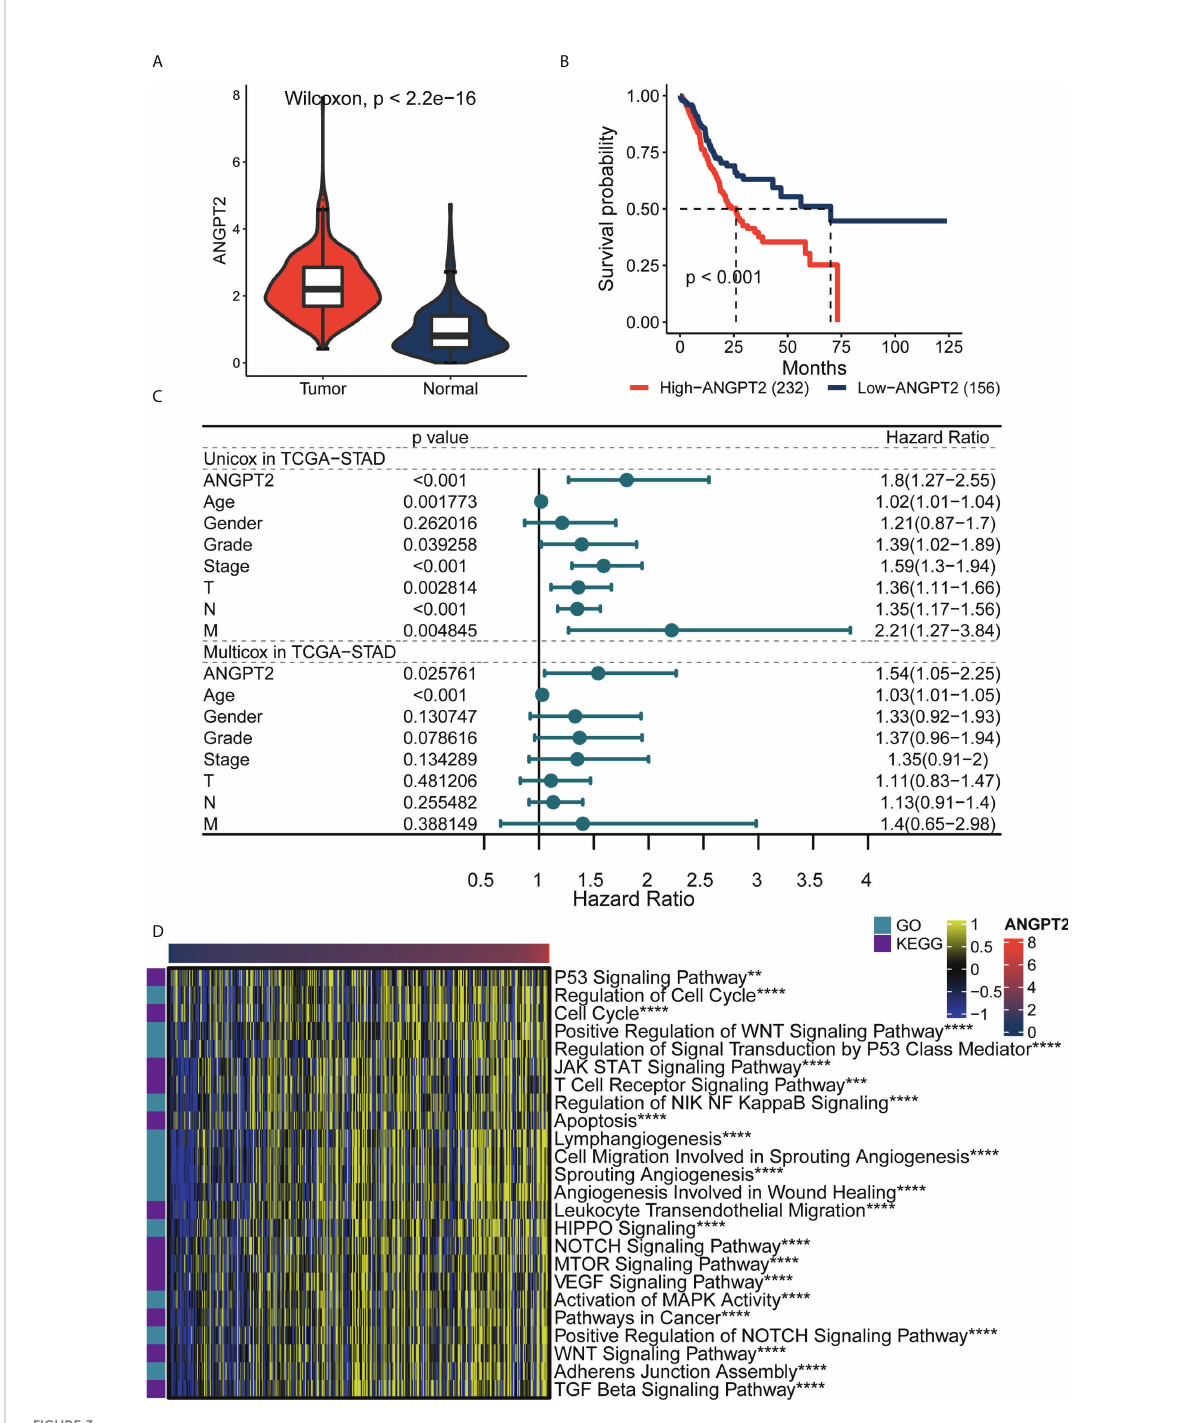
FIGURE 3 The importance of ANGPT2 gene in TCGA-STAD. (A) ANGPT2 expression level between STAD samples from TCGA cancer database and TCGA paracancerous plus GTEx normal samples. (B) Kaplan – Meier curves of high and low ANGPT2 groups in TCGA data. (C) Forest map of univariate and multivariate cox regression based on TCGA dataset and clinical variables. (D) GSVA thermomaps show functional pathways (GO and KEGG cancer-related pathways) signi fi cantly related to ANGPT2 in TCGA. **P < 0.01, ***P < 0.001 and ****P <